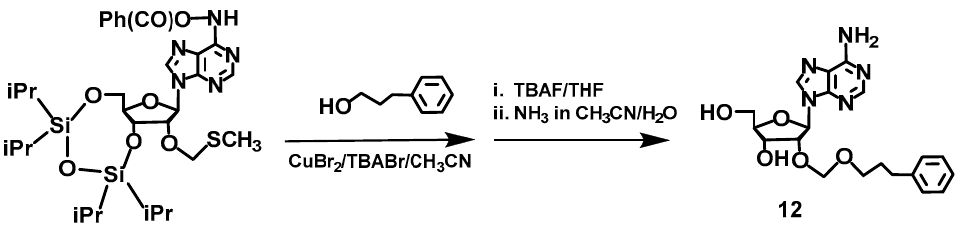
Figure 10. Synthesis of 2 ′ - O -(3-phenylpropyleneoxymethyl]-adenosine ( 12 ) from a key intermediate 6- N -benzoyl-3 ′ ,5 ′ - O , O -(tetraisopropyldisiloxane-1,3-diyl)-2 ′ - O -methylenethiomethyladenosine.